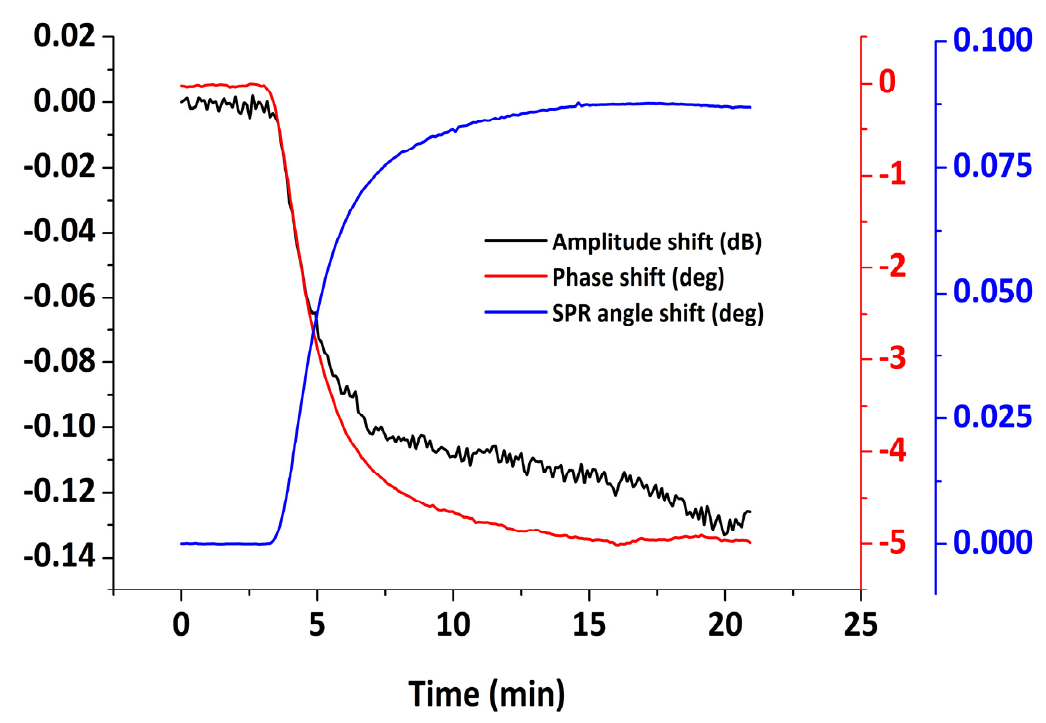
Figure 15. Real-time SPR, phase and amplitude responses upon BSA adsorption on Au.